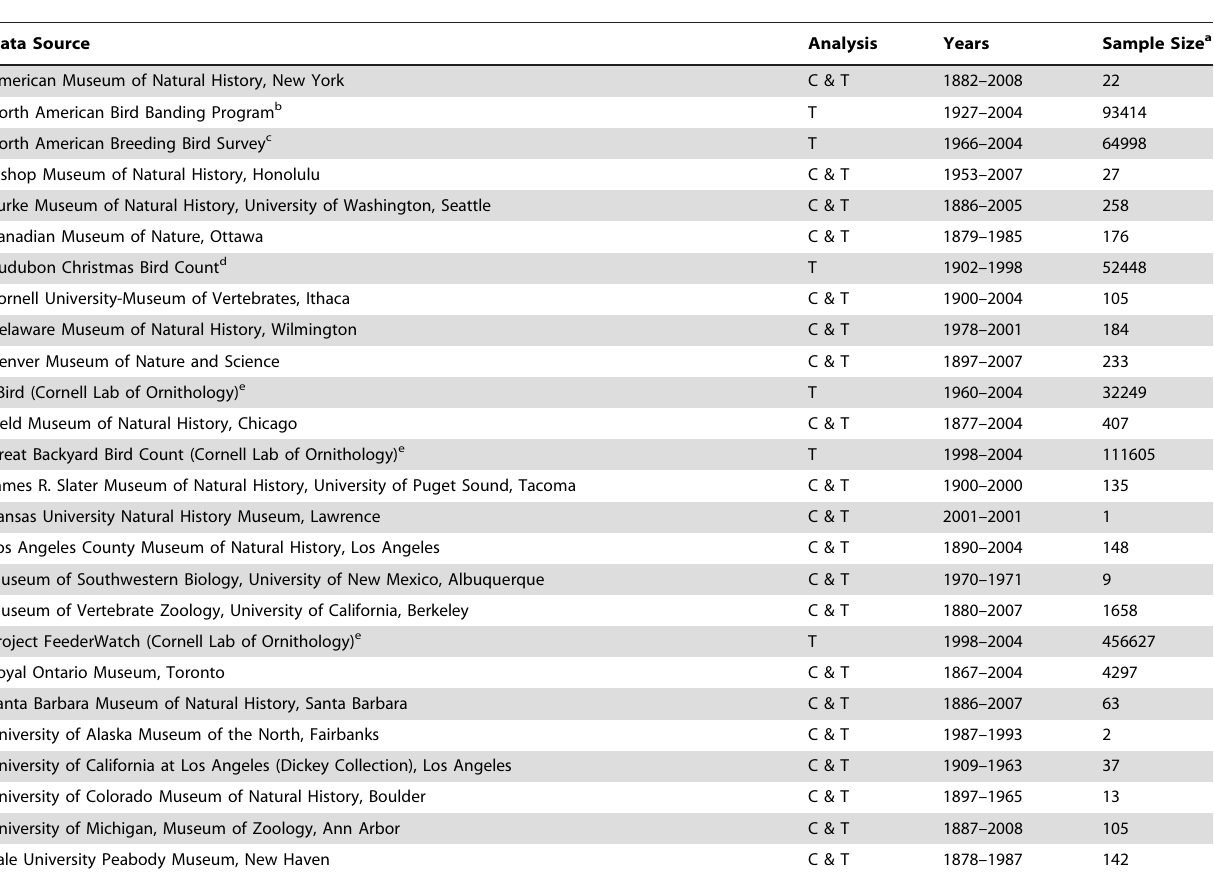
Table 2. Data sources used in the contemporary (C) and temporal (T) niche analyses, including years of coverage and raw sample